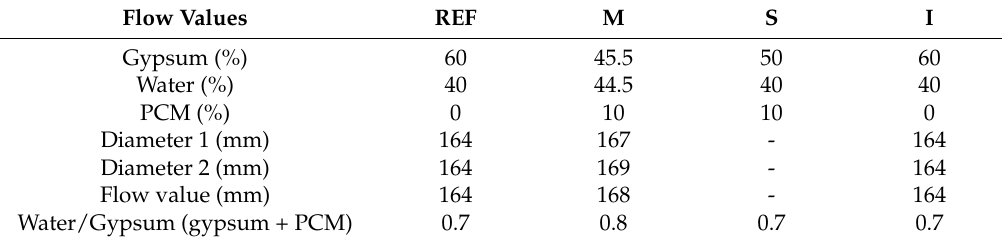
Table 2. Flow values and consistency.